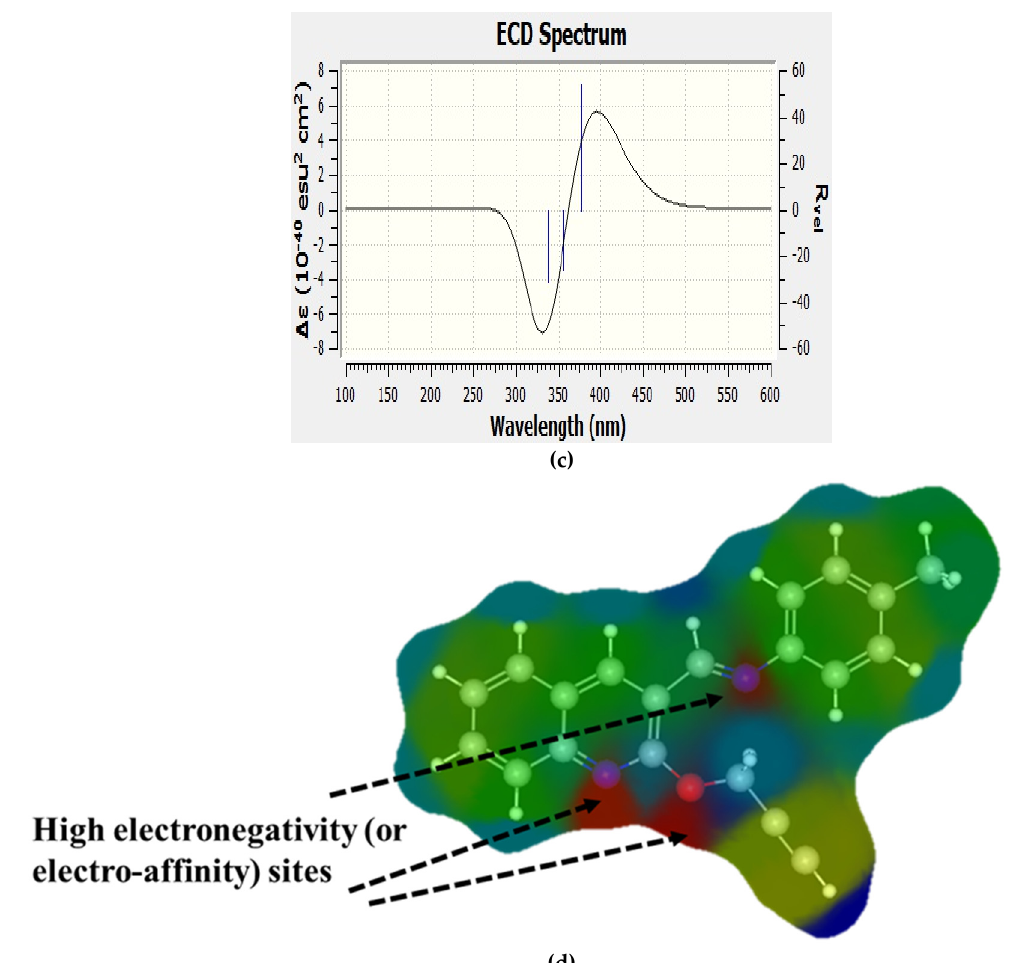
Figure 4. ( a ) Molecular orbital structure of 5d , simulated using the TD-DFT B3LYP method with 6–31G* basis set; ( b ) simulated US-VIS; ( c ) ECD spectra of 5d using TD-DFT B3LYP method with 6–31G* basis set; (d ) calculation of charge distribution of 5d in reverse rainbow scale.